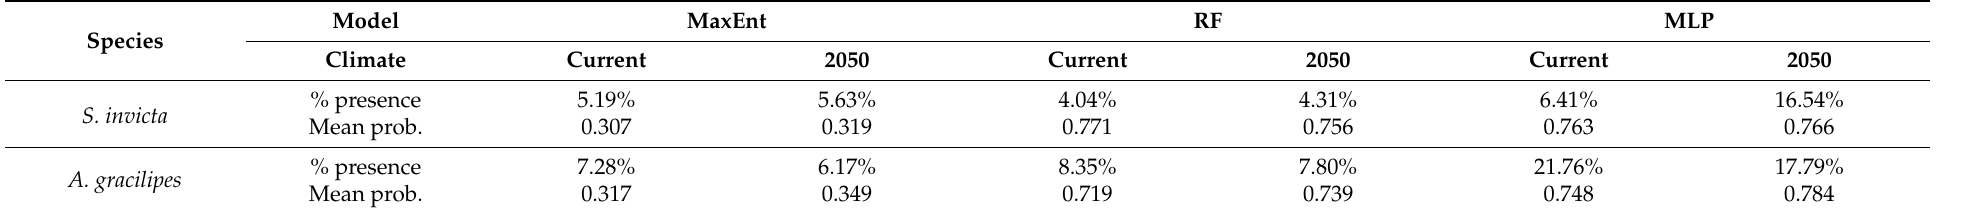
Figure 2. Classification of potential presence and absence areas for S. invicta by each model and climate change scenario. Table 3. Areal ratio and average probability of potential distribution by models and